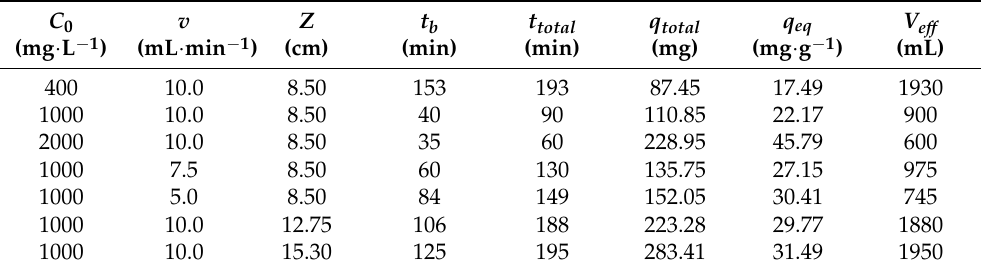
Table 2. Data on column and their acquired parameters at different influent phenol concentrations, rates of flow, and bed depths onto rice husk activated carbon (RHAC) (temperature = 23 ± 1 °C; pH = 5.58).